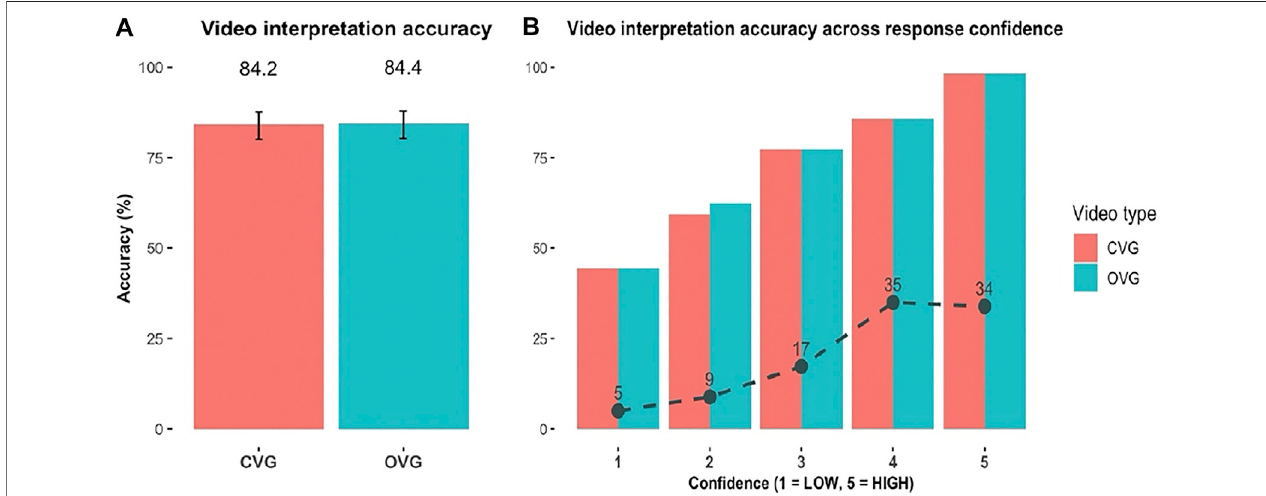
FIGURE4| ThebarplotsshowmeanpercentagesofaccuratelyrecognizingCVGandOVGvideos.Panel (A) showsthemeanaccuracyforthetwotypesofvideos (thecon fi denceintervalsarecalculatedusingprop.test()functioninR).Panel (B) showsaccuracyacross fi velevelsofresponsecon fi dencewith “ 1 ” denotingleastand “ 5 ” mostcon fi dentresponses.TheoverplotteddotsjoinedwithadashedlineinPanel (B) showpercentagesofresponsesineachlevelofthecon fi dencescale(thenumbers above the dots are the percentages).